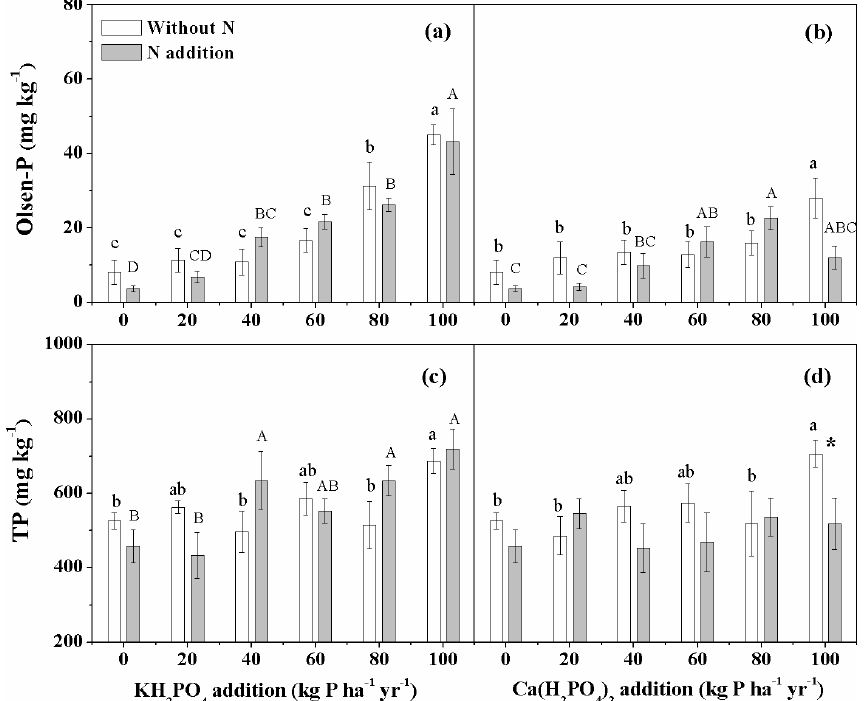
Figure 5. Effects of phosphorus (P) and nitrogen (N) additions on soil Olsen-P and total P (TP) in the meadow steppe. Phosphorus types include KH 2 PO 4 and Ca ( H 2 PO 4 ) 2 at rates of 0, 20, 40, 60, 80 and 100kgPha − 1 yr − 1 . Data are represented as mean ± standard error. Letters indicate significant differences between P rates of KH 2 PO 4 or Ca ( H 2 PO 4 ) 2 addition without N (lowercase letters) and with N addition (capital letters). Asterisks represent significance between N treatments within each P type and rate ( ∗ and ∗∗ for P < 0 . 05 and 0.01,